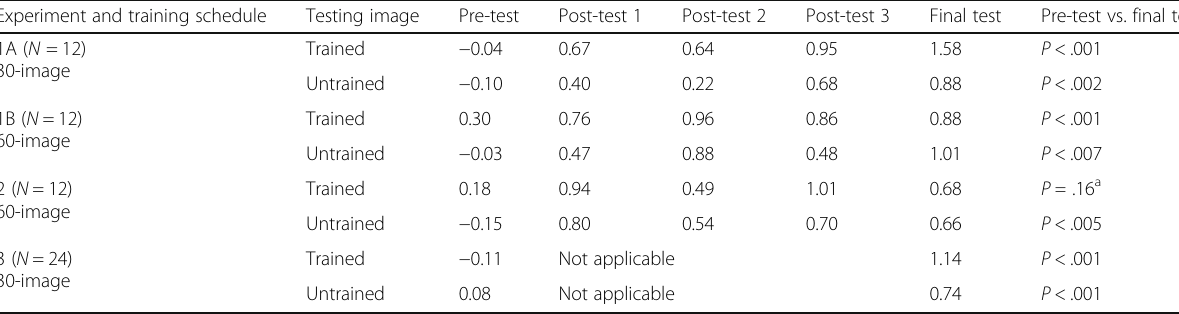
Table 2 Mean d ’ for intact images used in the testing sessions Experiment and training schedule